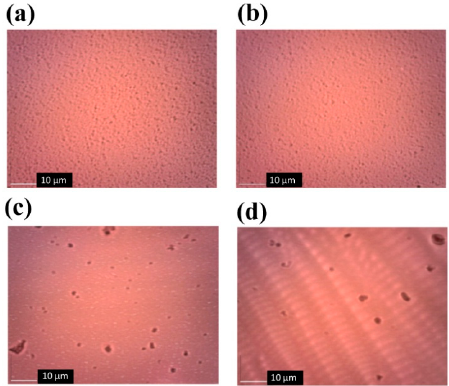
Figure 3. The optical microscope (OM) images of [6,6]-phenyl-C61-butyric acid methyl ester (PCBM) electron transport layers (ETLs) based on the ( a ) DCB, ( b ) CB, ( c ) MB, and ( d ) CF solvents.